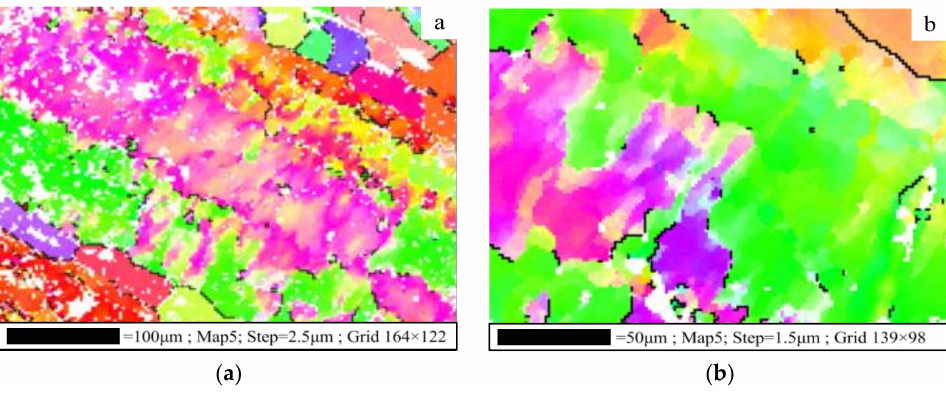
Figure 12. Microstructure of aluminum alloy 7050-T7451 in TD: ( a ) EBSD 500 × ; ( b ) EBSD 1000 × .